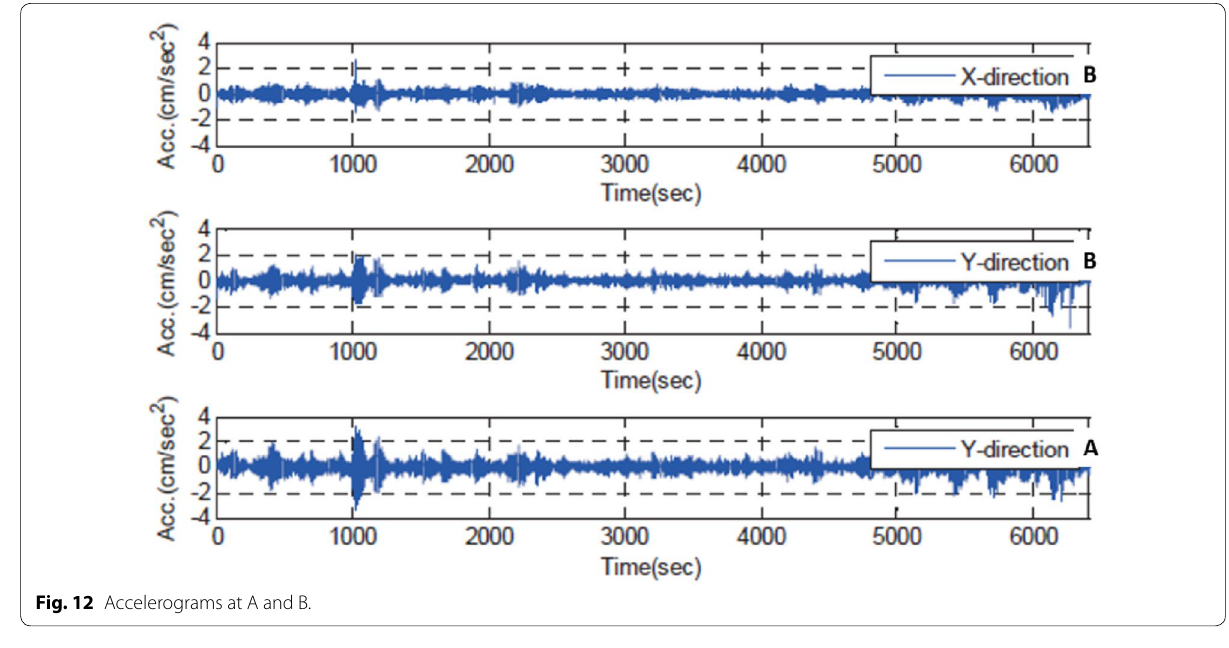
Fig. 12 Accelerograms at A and B.